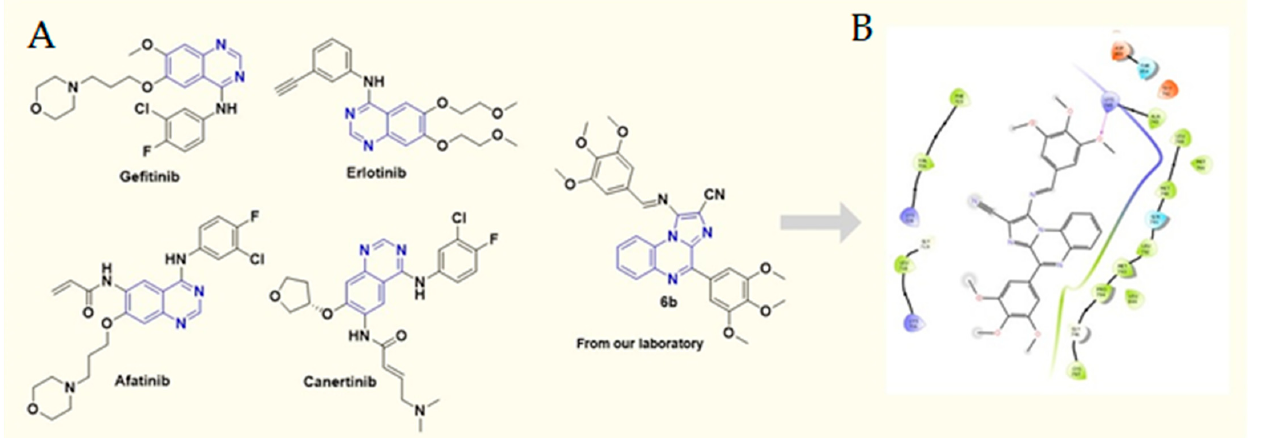
Figure 1. ( A ) Chemical structures of various FDA-approved EGFR inhibitors and 6b ; ( B ) 2D docking pose of 6b at the active site of mutant (L858R/T790M) EGFR (PDB ID: